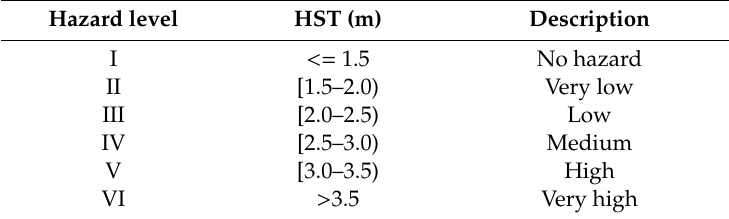
Table 2. The classification of hazard levels corresponding to the ranges of the potential highest storm tides (HSTs).